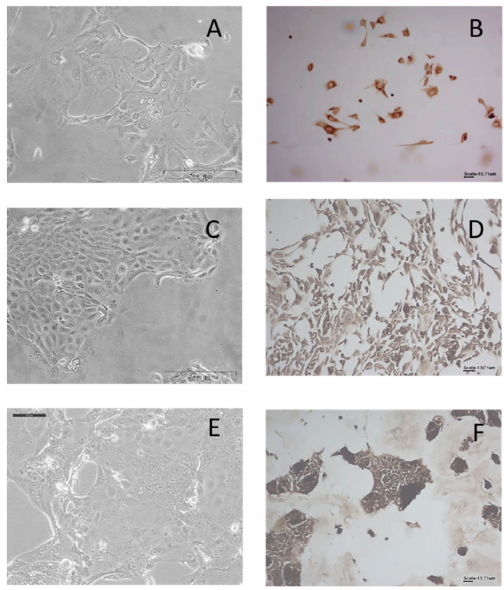
Figure 2. Brightfield images of cell morphology and immunohistochemical staining of PDX-derived tumour cells using primary antibody Anti-Mitochondria antibody 113–1 (1:1000 dilution) of PIN 080 ( A , B ) PIN 099( C , D ) and PIN 127 ( E , F ). A, C and E were imaged at 20 × , and B, D and F were imaged at 10 × .